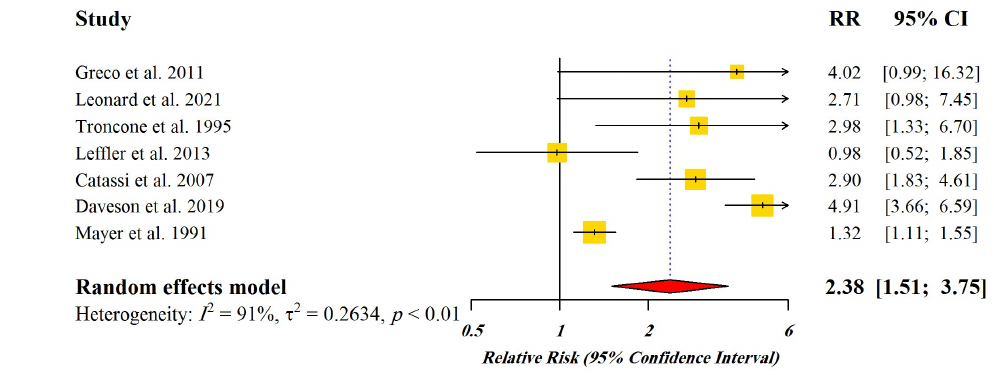
Figure 2. Forest plot of pooled relative risks (RR) with 95% CI for included studies [4,21,33–37]. Yellow Squares: Point estimate of risk ratio, Red Diamond: Total estimate of risk ratio.